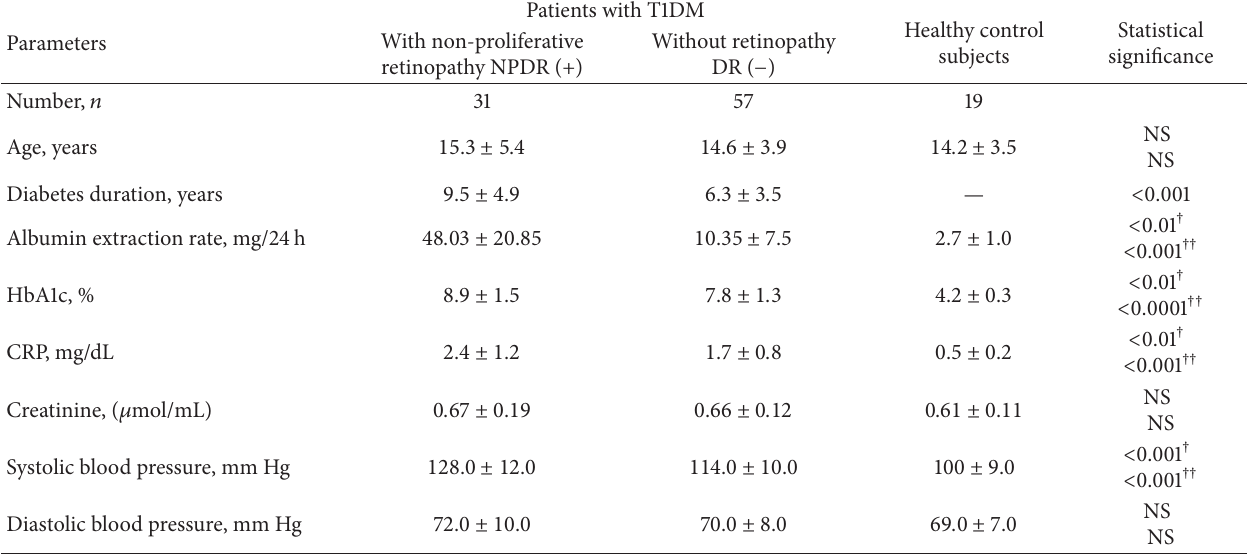
Table 1: Basic clinical parameters in the juvenile patients with T1DM and the control subjects.